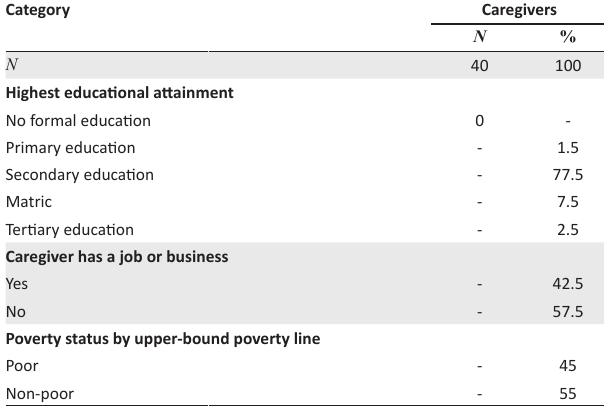
TABLE 1: Child characteristics. Category